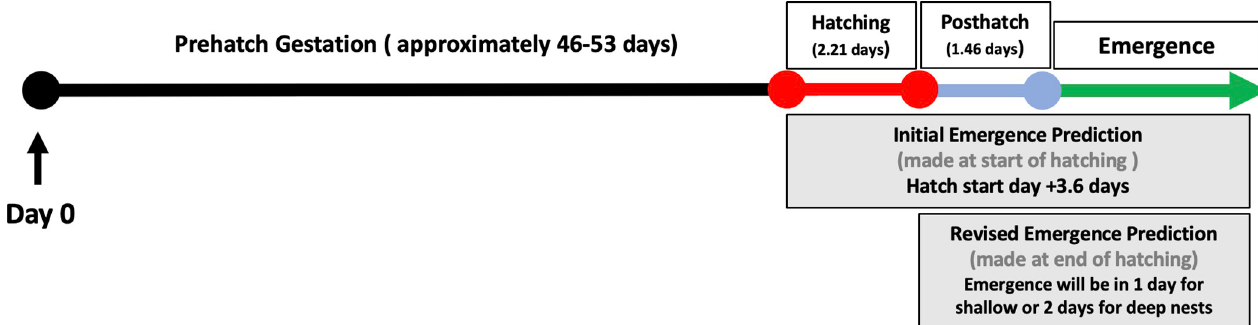
Fig 5. TurtleSense can be used to accurately predict emergence. Once egg hatching activity is detected, emergence onto the sand will occur on average in 3.6 days. When the end of hatching is detected, typically turtles will emerge in 1 day from shallow nests ( < 31 cm) and in 2 days in deep nests ( > 31 cm), based on a significant correlation between the posthatch period and nest